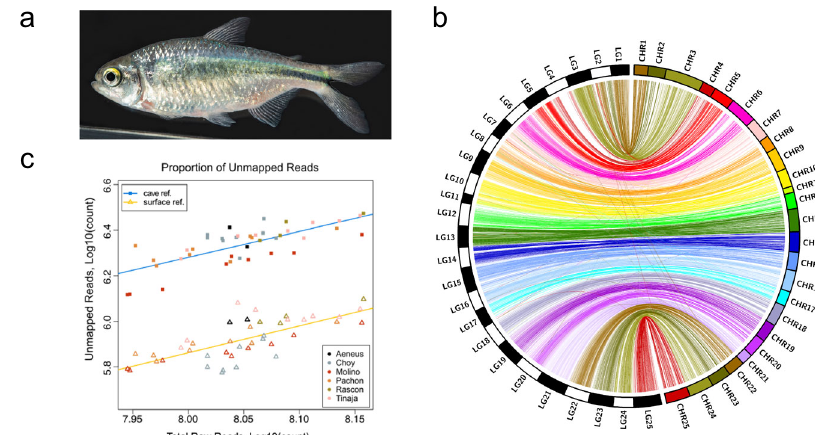
Fig. 1 Assembly metrics for the surface fi sh genome Astyanax mexicanus 2.0. a Adult Astyanax mexicanus surface fi sh. b Substantial synteny is evident between a recombination-based linkage map 30 and the draft surface fi sh genome. By mapping the relative positions of genotyping-by-sequencing (GBS) markers from a dense map constructed from a Pachón × surface fi sh F 2 pedigree, we observed signi fi cant synteny based on 96.6% of our genotype markers. c Proportion of unmapped reads for the same samples aligned to the cave (square points) and surface (triangle points) Astyanax reference genomes. Colors unite samples by population identity. Best fi t lines for each alignment (cave: blue, surface: yellow) have similar slope, indicating that population identity has a similar effect on mapping rate to either